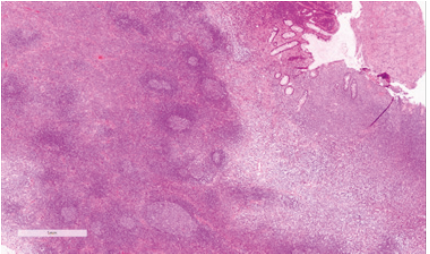
Figure 4: Lymphoid follicles were well-spaced and variably sized and